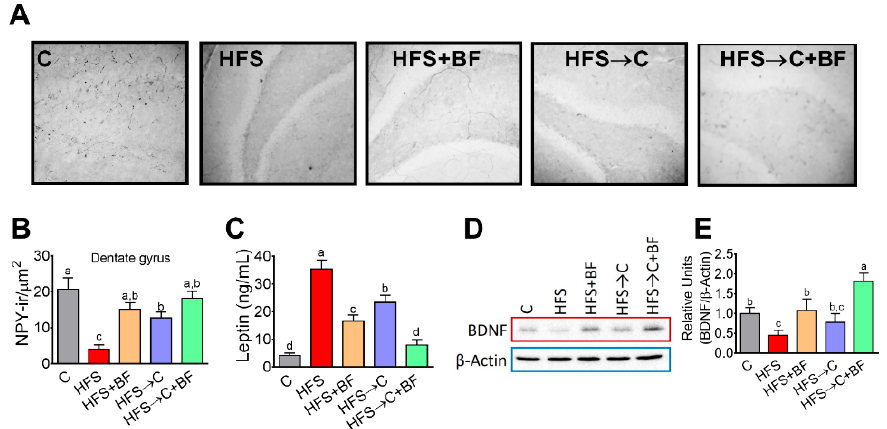
Figure 9. Neuropeptide Y in the dentate gyrus of the hippocampus were increased with bioactive foods. ( A ) NPY-ir in dentate gyrus, ( B ) quantification of NPY-ir, ( C ) serum leptin concentration ( D ) western blot analysis, and ( E ) protein abundance of BNDF in prefrontal cortex of rats fed control (C) or high fat diet + 5% sucrose (HFS) with or without bioactive foods. Data are expressed as the mean ± SD. Mean values with different letters show statistical differences between each other. Data were analyzed by one-way ANOVA followed by Tukey post-hoc test. Results were considered statistically significant at p < 0.05.